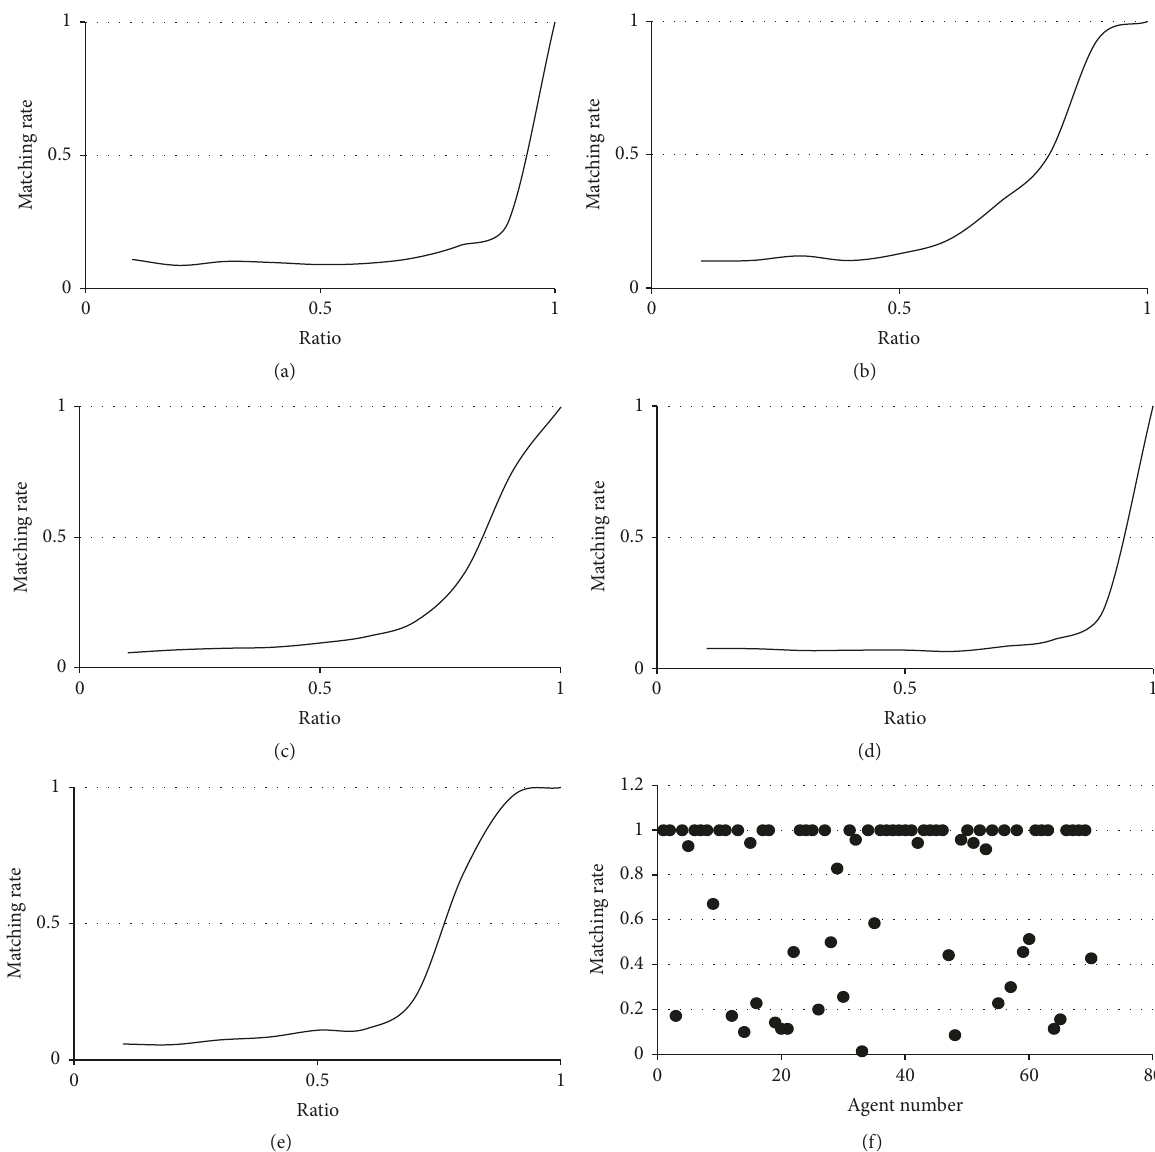
the average matching rate against data from rat99 was